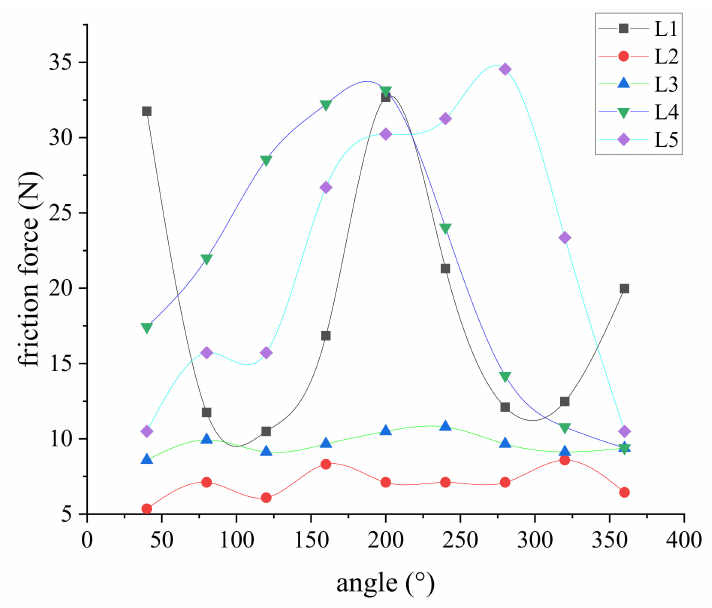
Figure 14. Predicted friction force in the sliding process. It is assumed that the friction force is evenly distributed on the circumference. The predicted and measurement results of the friction force at the axial Li of the cylinder